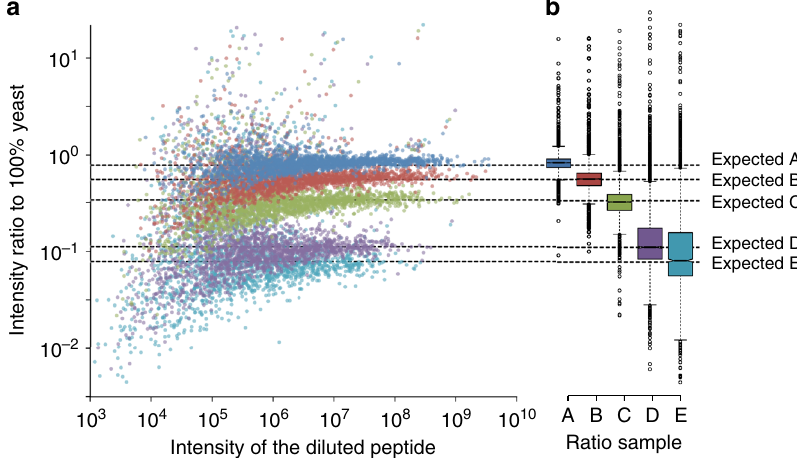
Fig. 5 Quantitative accuracy in mixed proteomes. a Quantitative ratios of 2018 yeast proteins spiked into a HeLa background at fi ve different concentrations and measured in triplicate. Each point indicates the average protein ratio relative to 100% yeast. b Boxplots showing the spread of the ratio measurements where boxes indicate medians and interquartile ranges, and whiskers indicate 5 and 95% values. The expected dilution ratios for samples A, B, C, D, and E are 78, 56, 34, 11, 7.8%